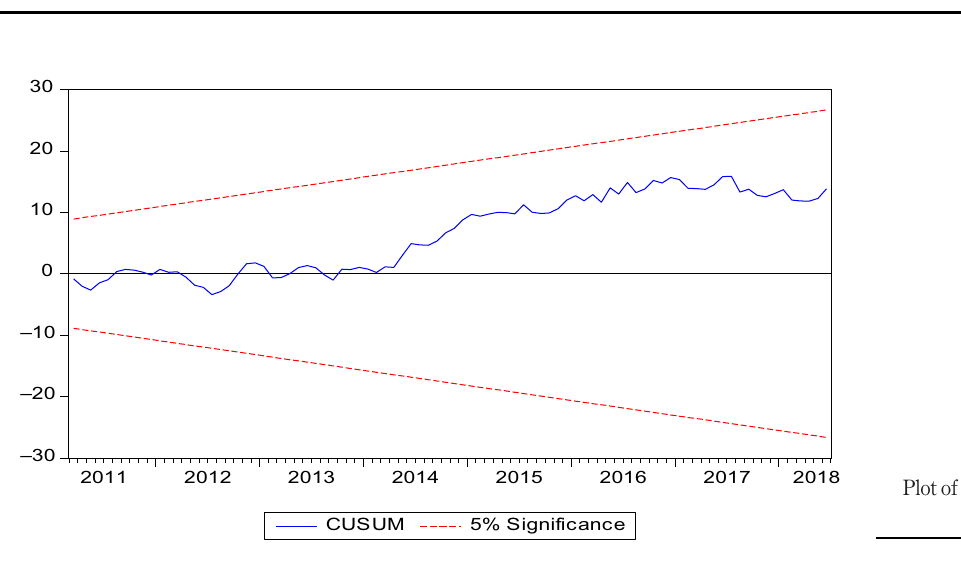
Figure 1. Plot of the CUSUM for